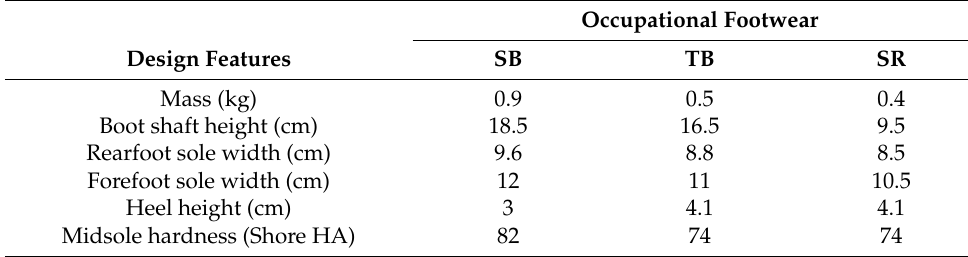
Table 1. Occupational footwear design